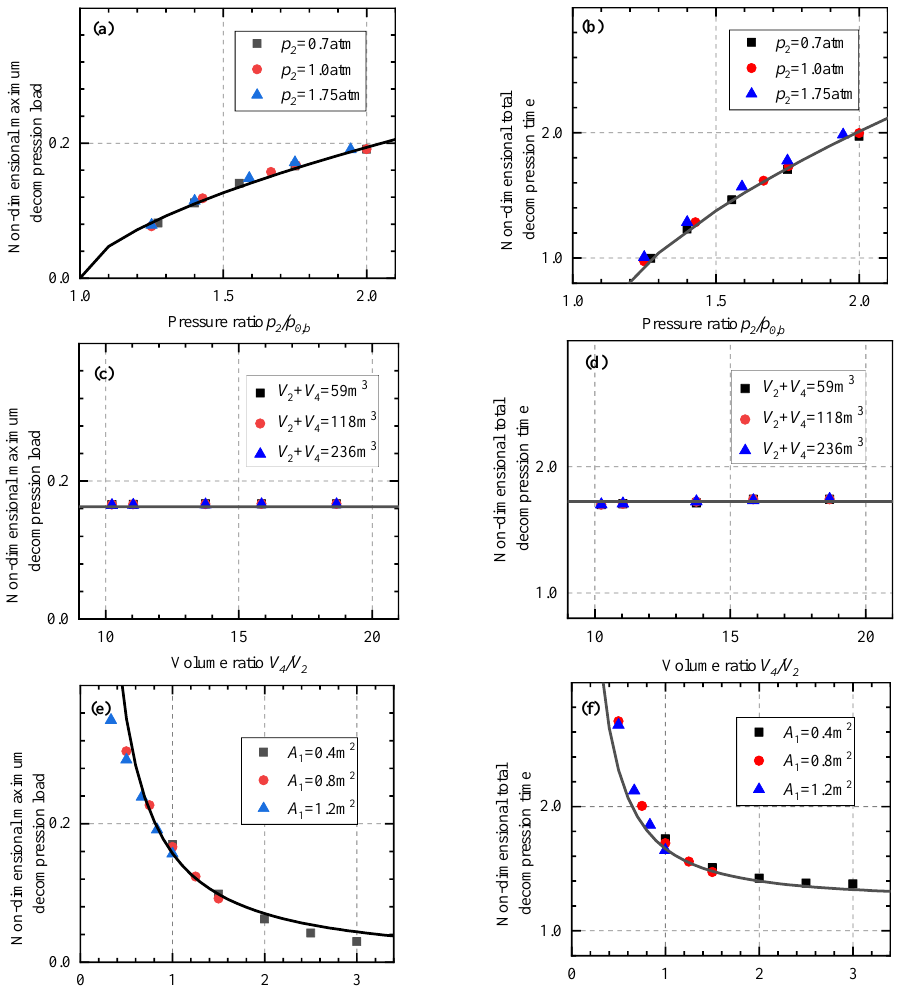
Figure 17. ( a ) Curve of non-dimensional maximum decompression load-pressure ratio, ( b ) curve of non-dimensional total decompression time-pressure ratio, ( c ) curve of non-dimensional maximum decompression load-volume ratio, ( d ) curve of non-dimensional total decompression time-volume ratio, ( e ) curve of non-dimensional maximum decompression load-area ratio, and ( f ) curve of non- dimensional total decompression time-area ratio.